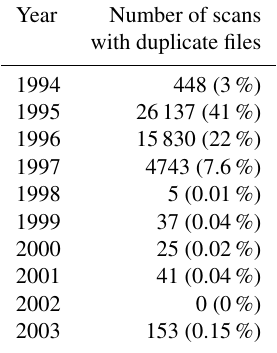
Table 3. List of duplicate file numbers by year. The percentages are relative to the number of scans in the